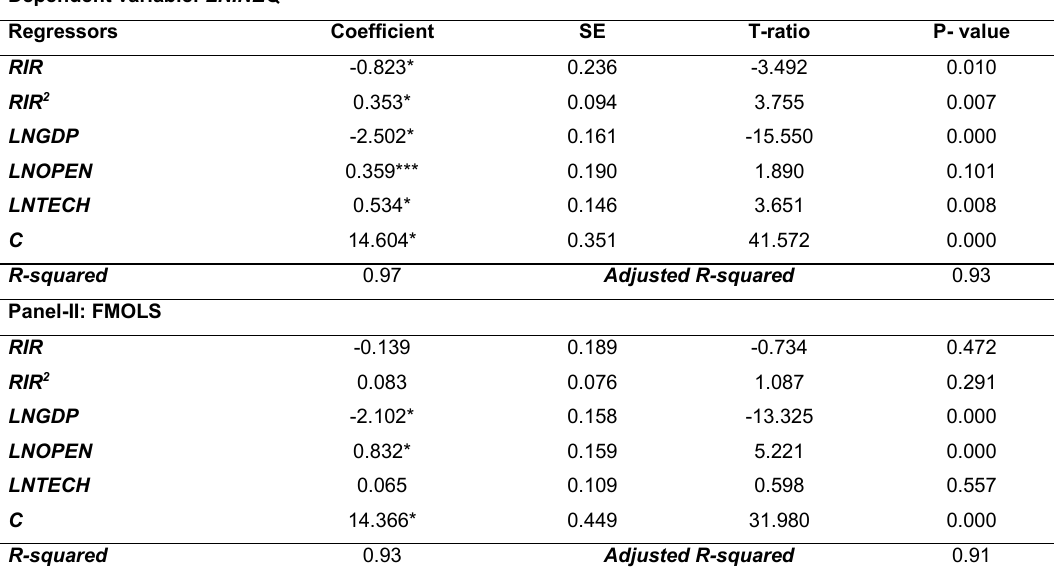
Table 6. DOLS and FMOLS